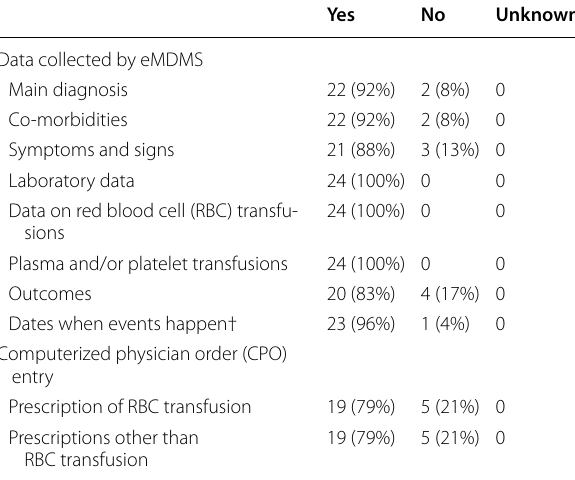
Table 1. Data management by eMDMS in 24